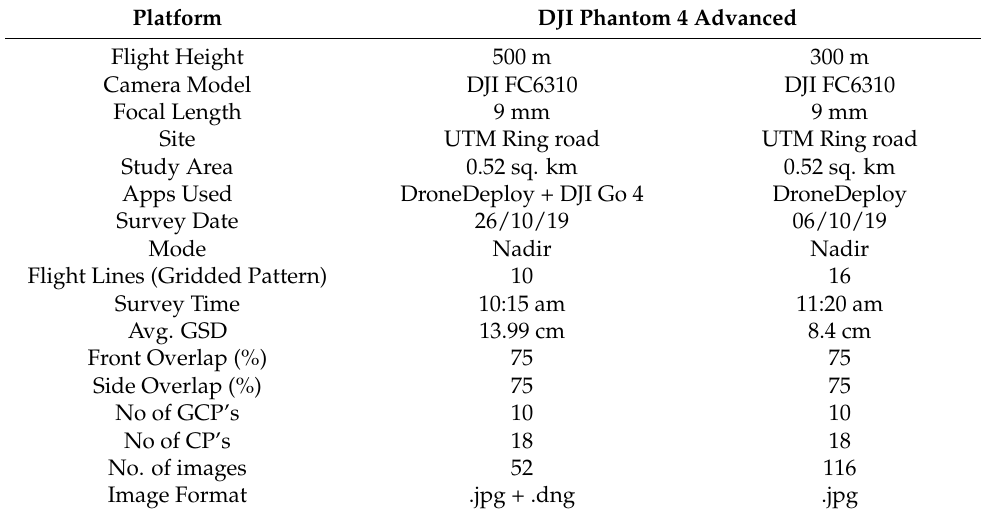
Table 1. Unmanned Aerial Vehicle (UAV) Flight Parameters.